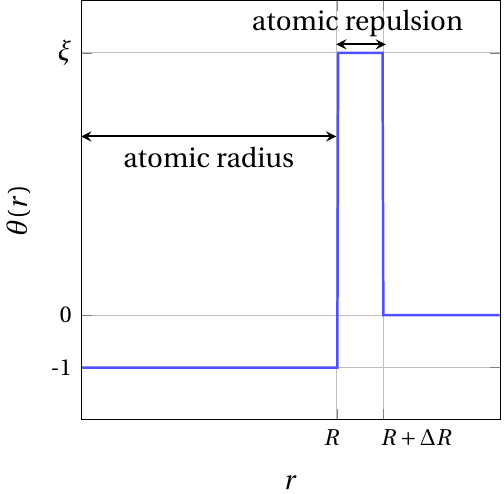
Figure 2. SR interaction θ α ( r ) step function